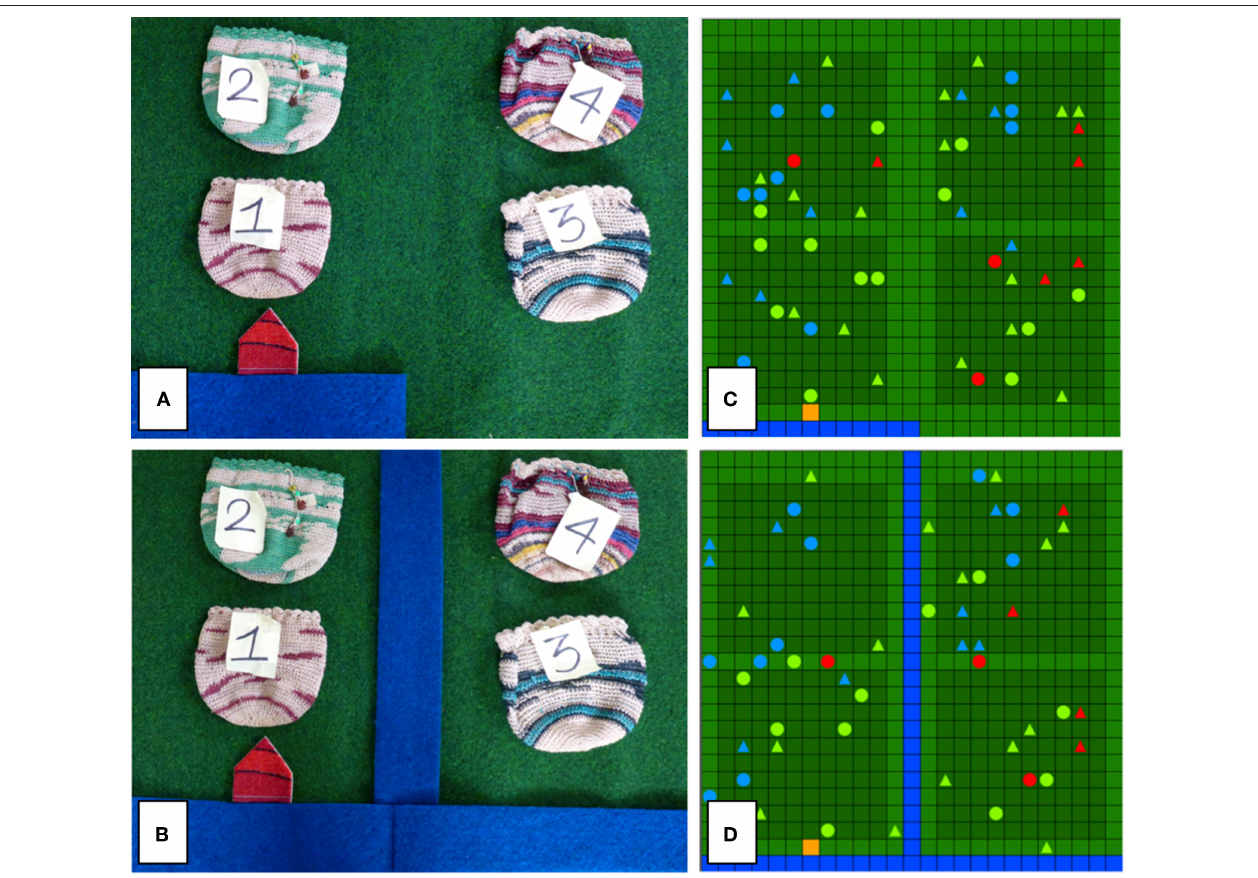
FIGURE 3 | Gameboard during low water (A) and high water (B) season and agent-based model interface during low water (C) and high water (D) season. The colors in the virtual interface represent the different game species: paca (green), peccary (blue), and tapir (red); the shapes distinguish the gender, females (circles), males